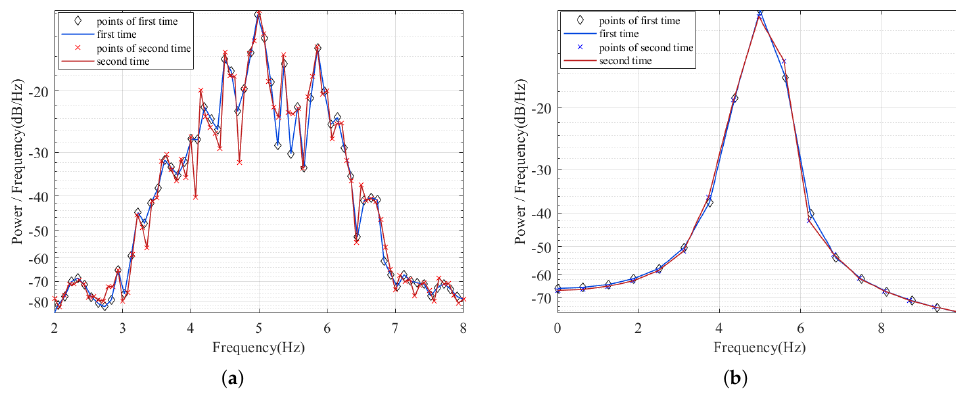
Figure 5. Comparison of estimation consistency. ( a ) Adopting the periodogram with Bartlett window for spectral estimation. ( b ) Adopting the Bartlett approach (average periodogram) for spectral